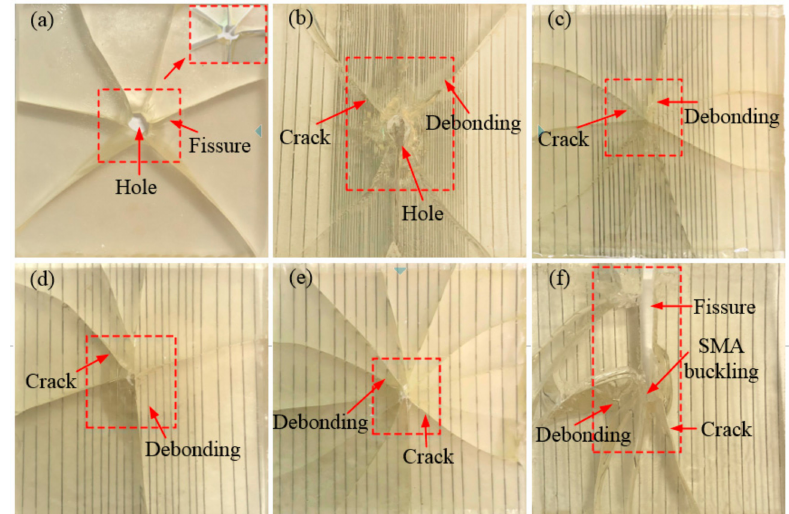
Figure 5. The failure modes diagrams of specimens with different SMA layup spacing values under 5 J of energy: ( a ) indicates the pure resin-matrix test specimen; ( b – f ) indicate the SMA reinforced resin-matrix test specimens with SMA layup spacing of 1, 2, 3, 4, 5 mm,